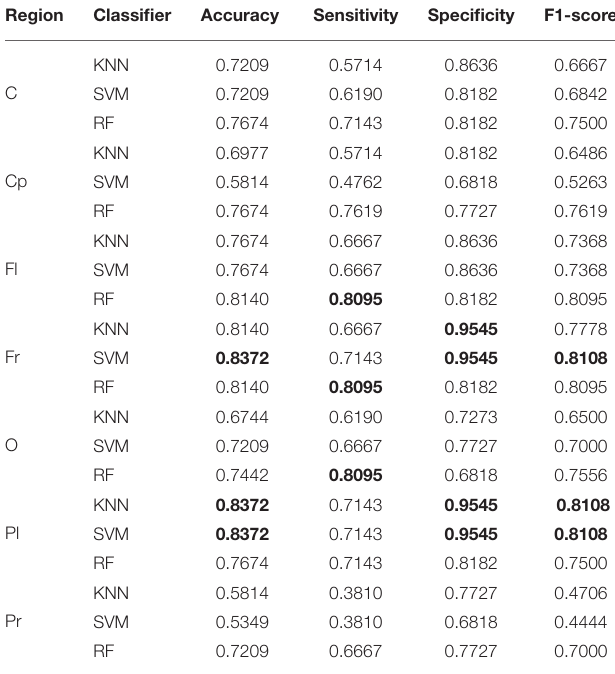
TABLE 3 | Classification results by all classifiers in different regions.